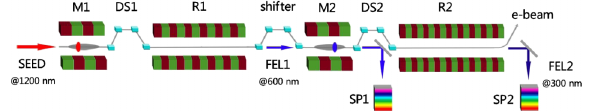
FIG. 5. Layout of the cascaded HGHG FEL experiments at the SDUV-FEL. M: modulator; DS: dispersive section; R: